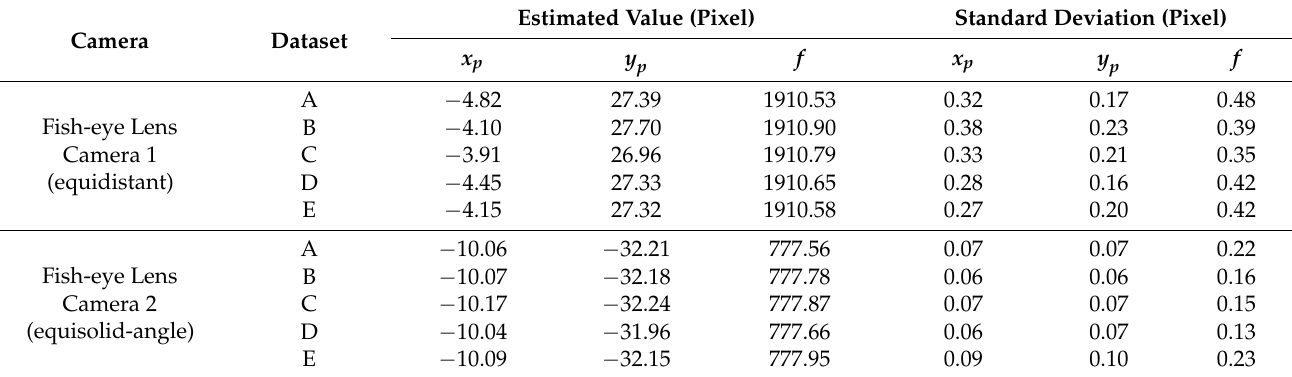
Table 11. Estimated values and standard deviations of principal point coordinates and focal length in real experiments. Camera Dataset